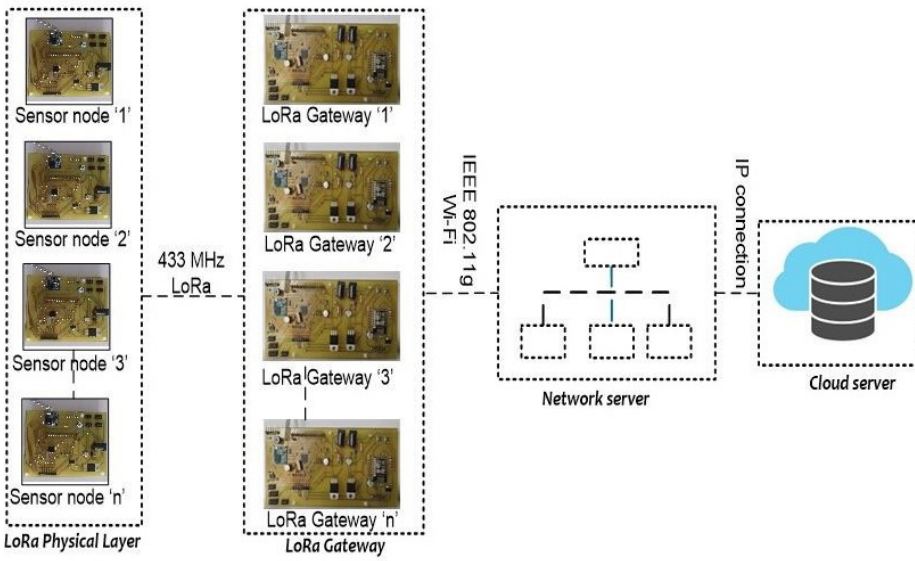
Figure 4. LoRa architecture for solid waste